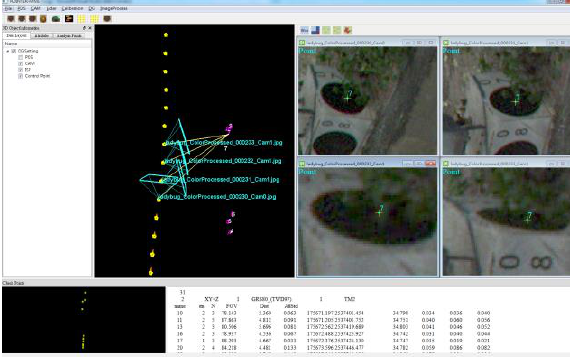
Figure 11: Measuring POIs and PointerMMS interface Table 3: DG accuracy of the MMS